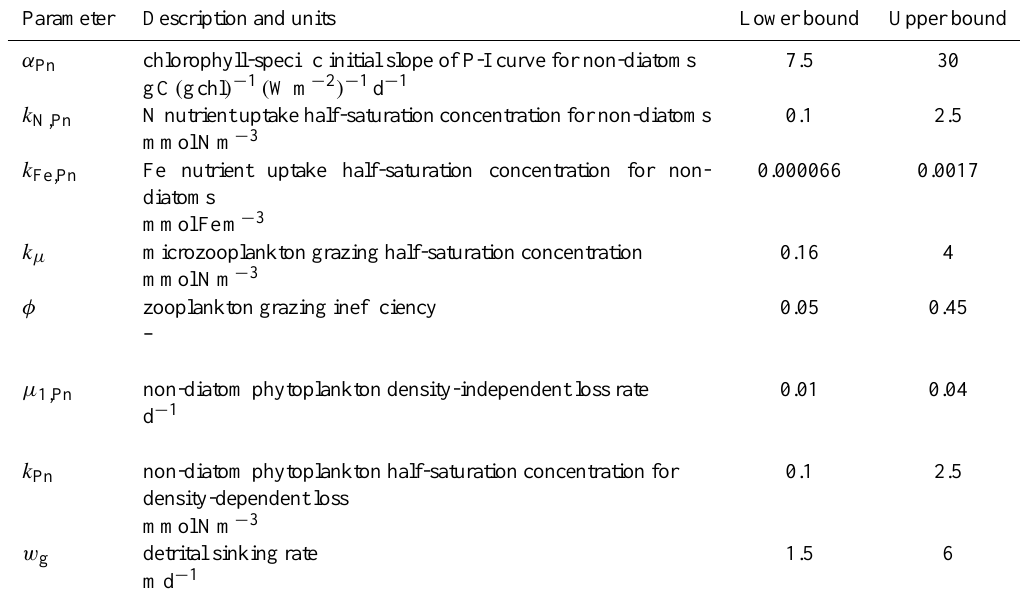
Table 1. 8-dimensional MEDUSA parameter space for target model emulation. Parameter Description and units